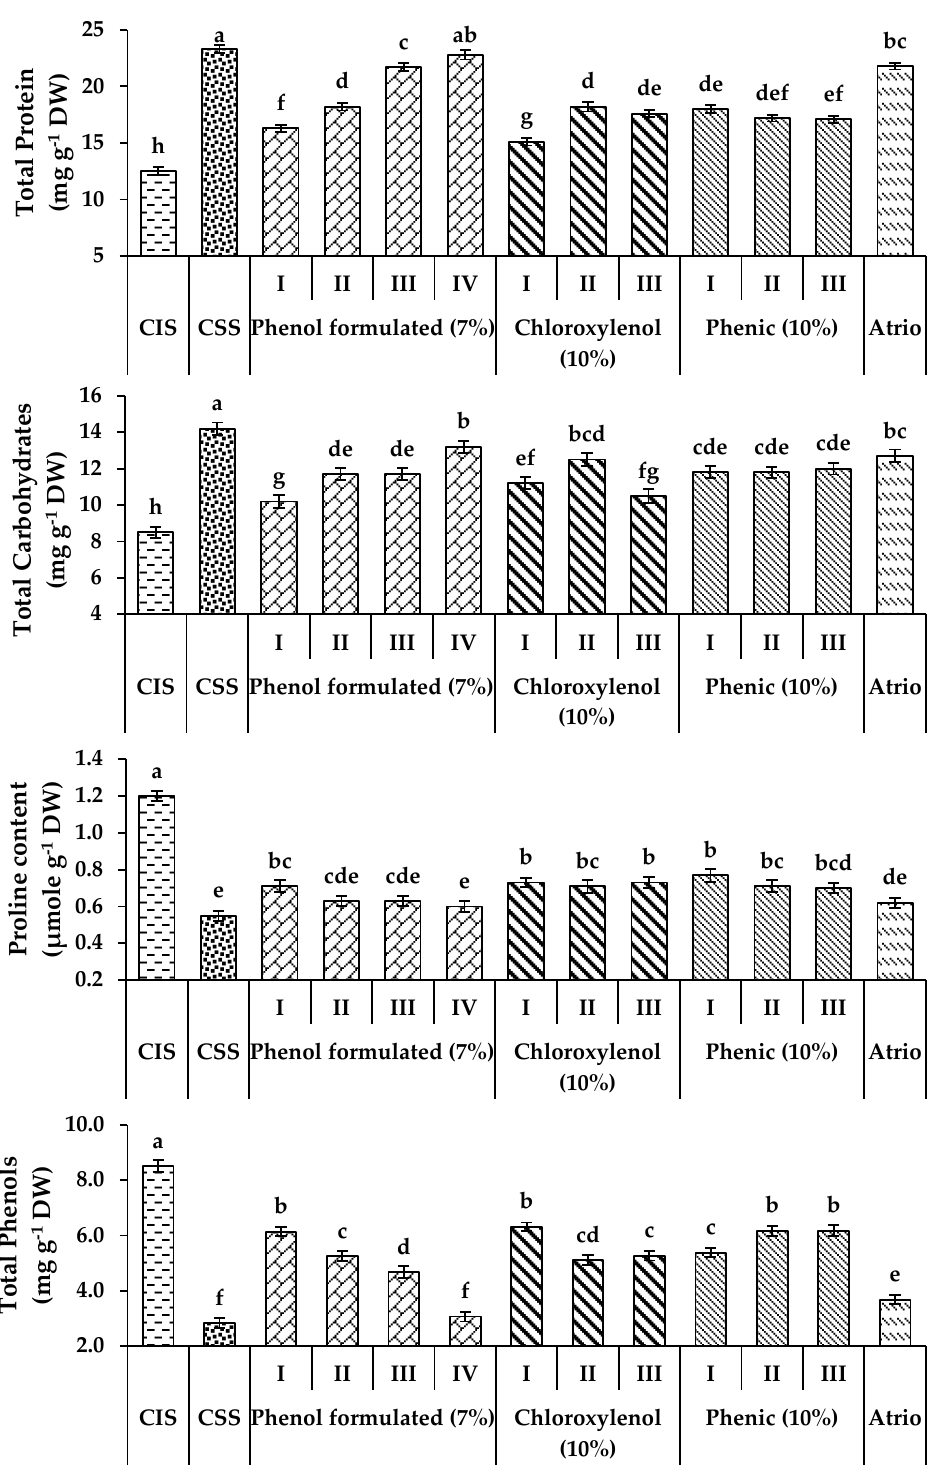
Figure 4. Effect of disinfectant agents at different concentrations and atrio 80% on chemical constituents of tomato seedlings infected by S. rolfsii at 35 DAP. CIS ; Control infected soil; CSS; control sterilized soil; (I) 125 µL 100 mL −1 ; (II) 250 µL 100 mL −1 ; (III) 500 µL 100 mL −1 ; (IV) 1000 µL 100 mL −1 . The values shown in the figures are means ± SEM ( n = 3), with different alphabetic letter/s being significantly different ( p < 0.05) following Tukey’s post hoc test.